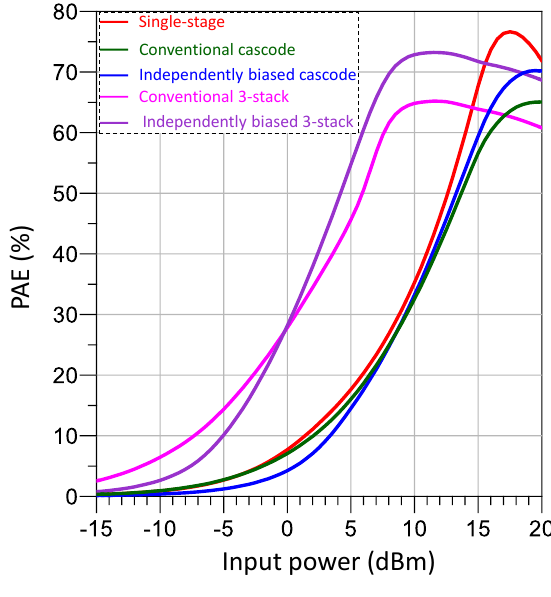
Figure 14. Efficiency characteristic.